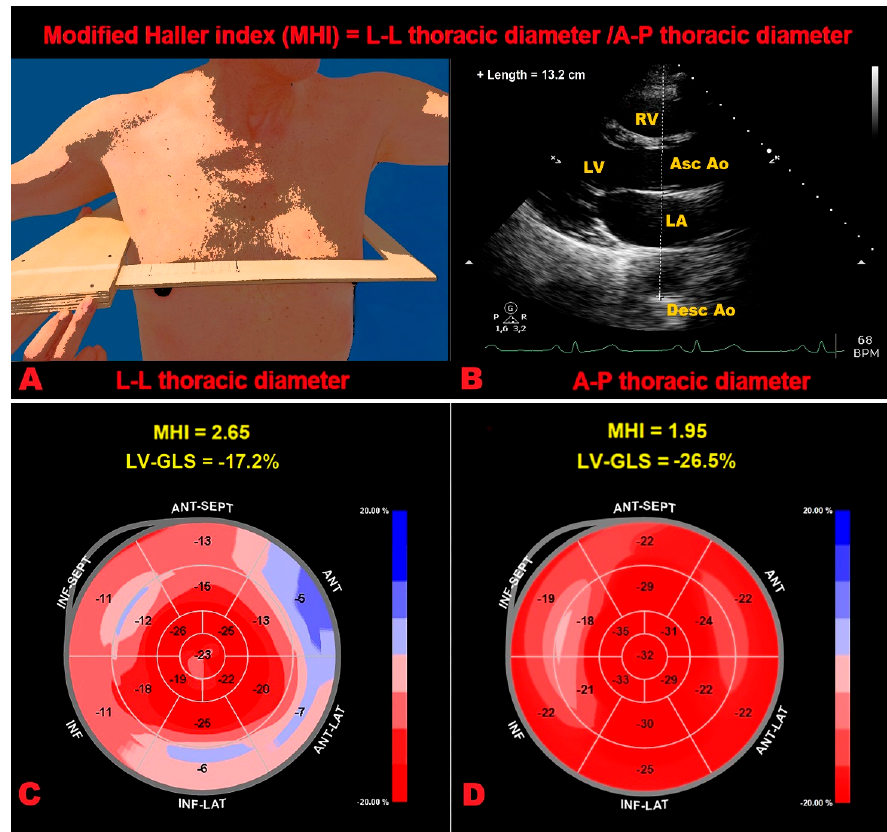
Figure 3. Modified Haller index measurement, obtained by dividing the L-L thoracic diameter ( A ) by the A-P thoracic diameter ( B ). The L-L thoracic diameter is measured with the subject in the standing position and with open arms, by using a rigid ruler in centimetres coupled to a level (the measuring device), placed at the distal third of the sternum, in the point of maximum depression of the sternum. The A-P thoracic diameter is measured, during conventional transthoracic echocardiography, as the distance between the true apex of the sector (the point of entry of ultrasound into the chest) and the posterior wall of the descending thoracic aorta, visualized behind the left atrium. A-P, anteroposterior; Asc ao, ascending aorta; Desc Ao, descending aorta; LA, left atrium; L-L, latero- lateral; LV, left ventricle; RV, right ventricle. Examples of LV-GLS bull’s eye plot patterns obtained in two healthy subjects, with PE ( C ) and with normal chest shape ( D ), respectively. The PE subject (MHI >2.5) was found with a significant impairment in basal myocardial strain (light pink and pale pink segments), moderate impairment in mid myocardial strain (light red segments) and with a normal apical strain (bright red segments); the resultant LV-GLS ( − 17.4%) was moderately impaired. On the other hand, the subject with normal chest wall conformation (MHI ≤ 2.5) was found to have a uniformly red pattern of the bull’s eye plot, indicating normal regional and global longitudinal deformation of myocardial segments (LV-GLS = − 27.2%). GLS, global longitudinal strain; LV, left ventricular; MHI, modified Haller index; PE, pectus